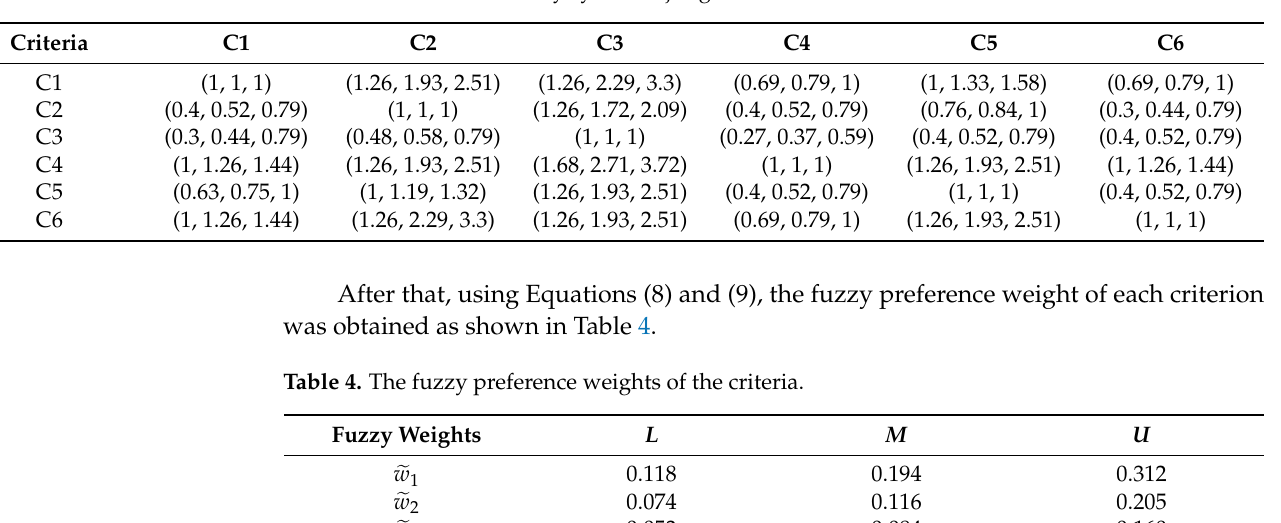
Table 3. The fuzzy synthetic judgment matrix.